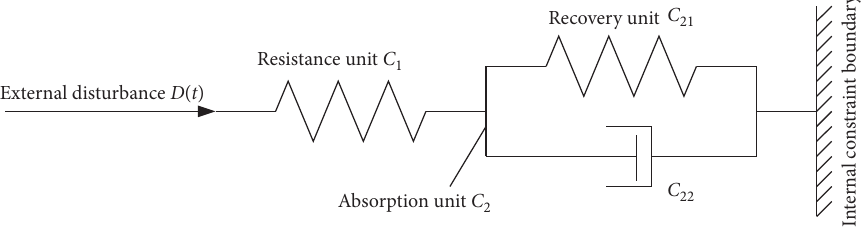
Figure 4: Qualitative model of cross-city transportation network